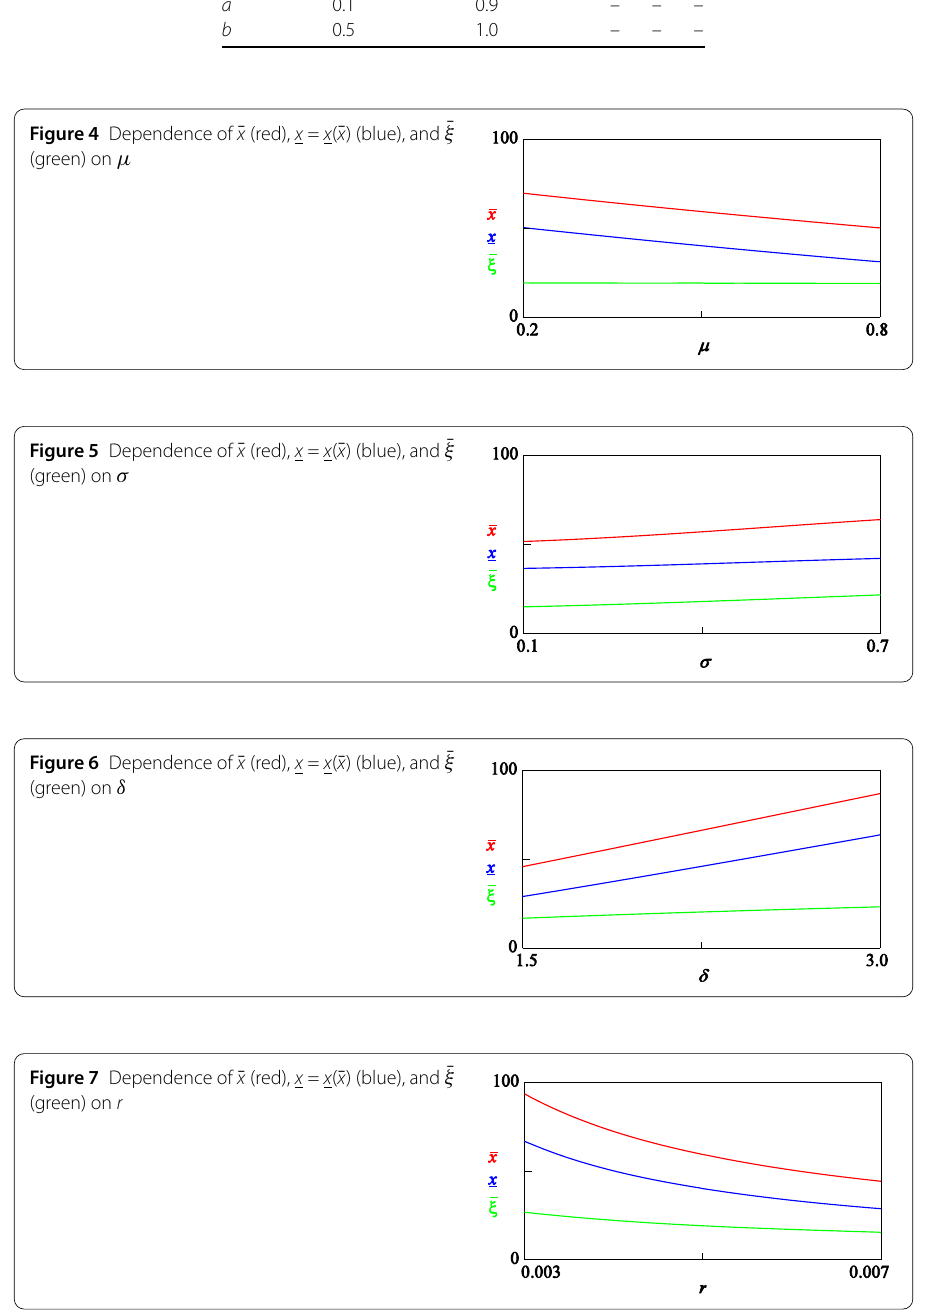
Figure 7 Dependence of ¯ x (red), x = x ( ¯ x ) (blue), and ¯ ξ (green) on